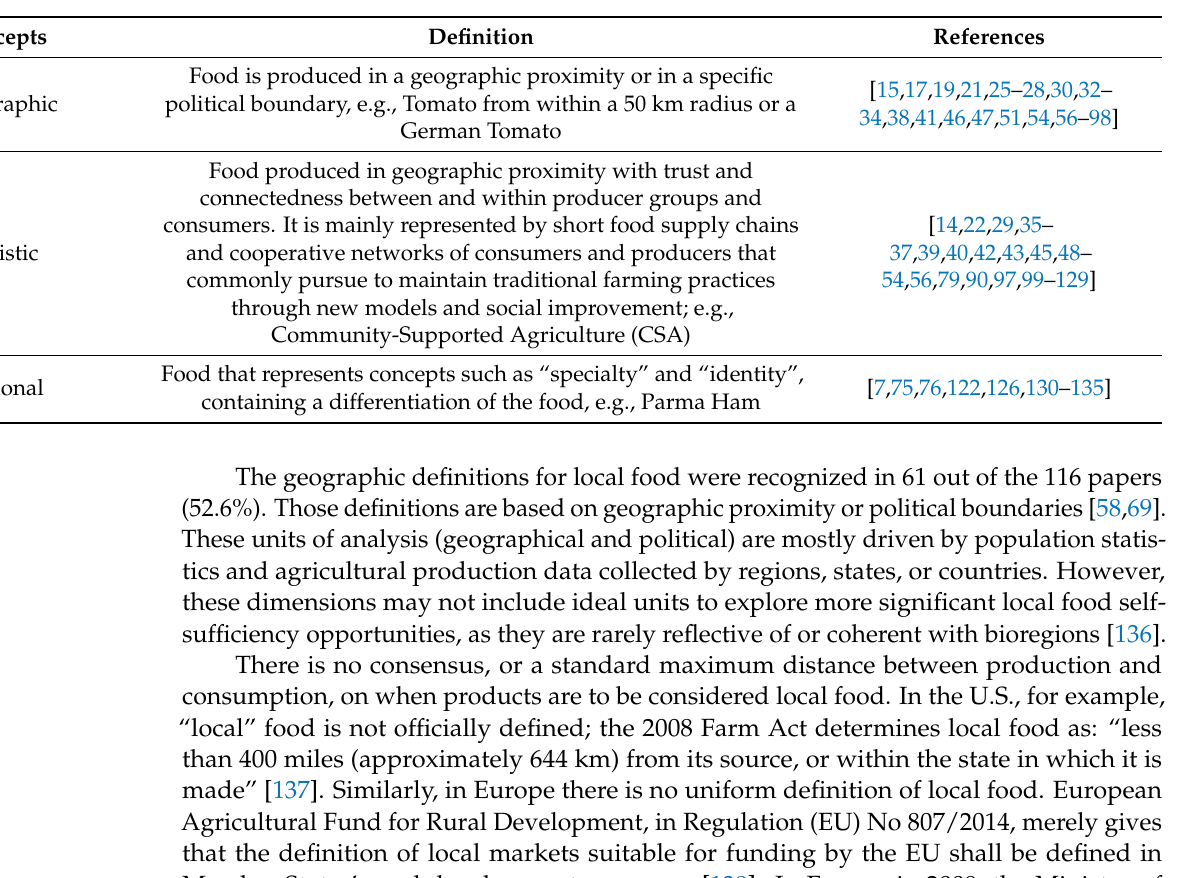
Table 3. Identified concepts and relative definitions use for local